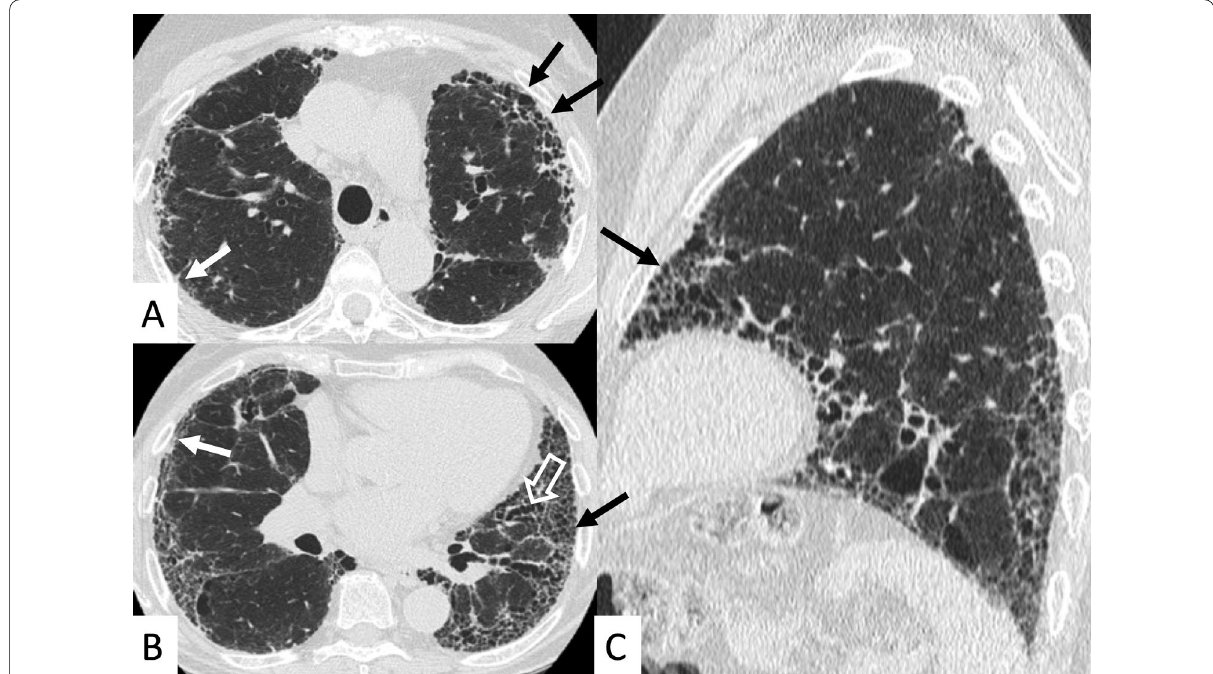
Fig. 1 Axial ( A , B ) and sagittal ( C ) HRCT images of a UIP pattern in a 72-year-old patient with rheumatoid arthritis. The images show the typical UIP pattern, predominantly located on basal and subpleural regions, and represented by honeycombing areas (black arrows in A – C ), reticulations (white arrows in A , B ) and traction bronchiectasis (white empty arrow in B